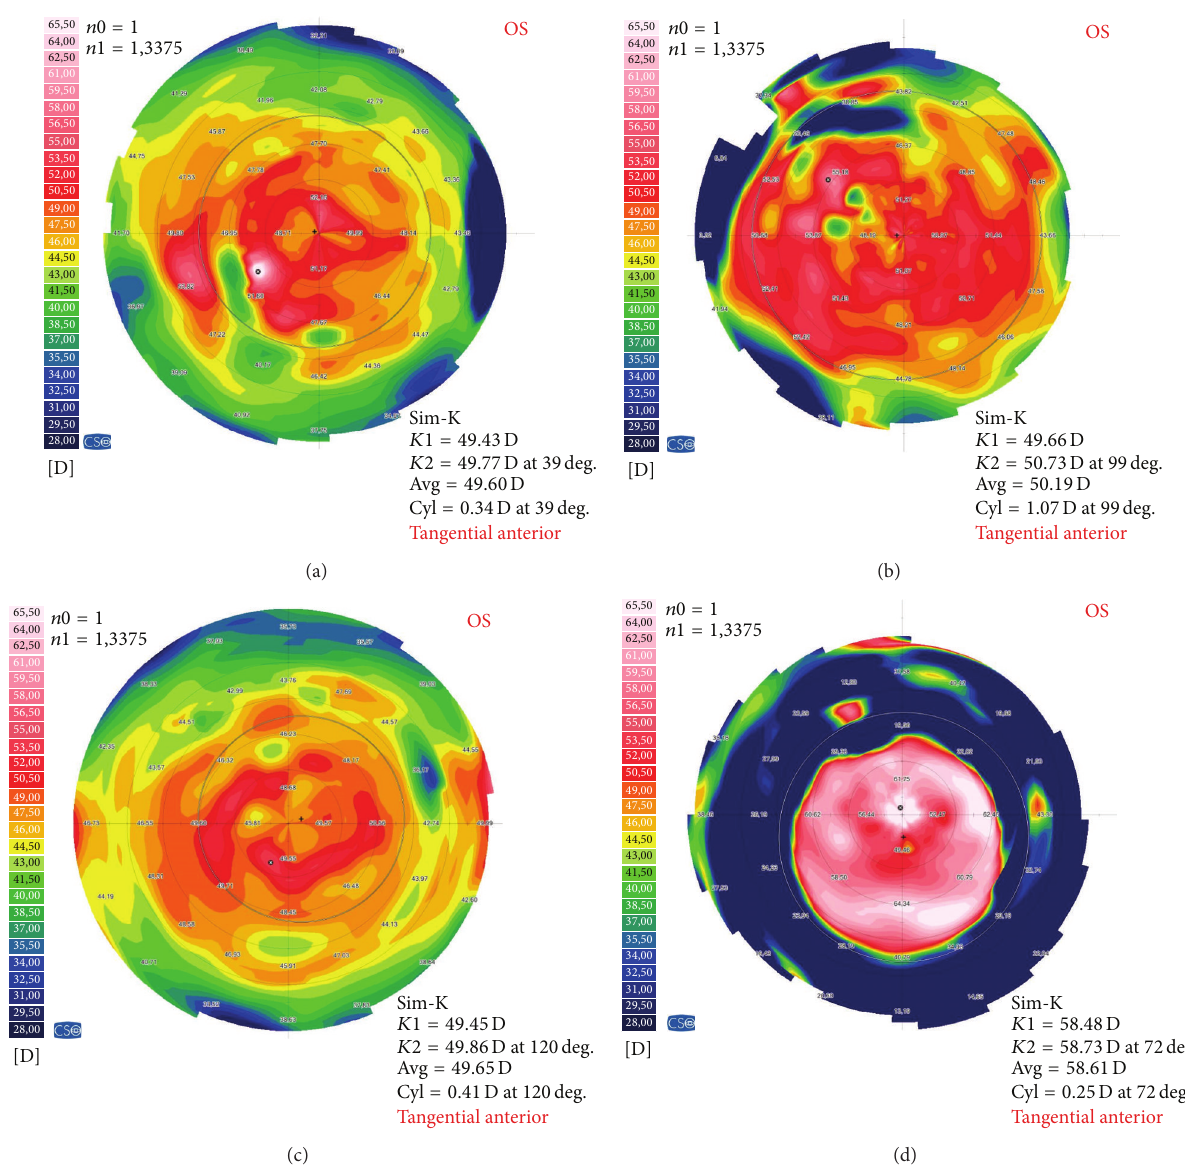
Figure 2: Topography display of treated cornea (Sirius, CSO, Firenze, Italy). (a) Group 1 (therapy power, 1W). (c) Group 3 (therapy power, 3 W). Tangential curvature of the anterior corneal surface before HIFU treatment. (b, d) Tangential curvature of the same cornea after HIFU treatment. It shows steepening in the central cornea and flattening outside. Sim-K: simulated keratoscope readings, K 1: the curvature in the flat meridian, K 2: the curvature in the steep meridian, Avg: the mean curvature, Cyl = cylinder, deg.: degree, D: diopter, OS: left eye, and tangential anterior: tangential curvature of the anterior corneal